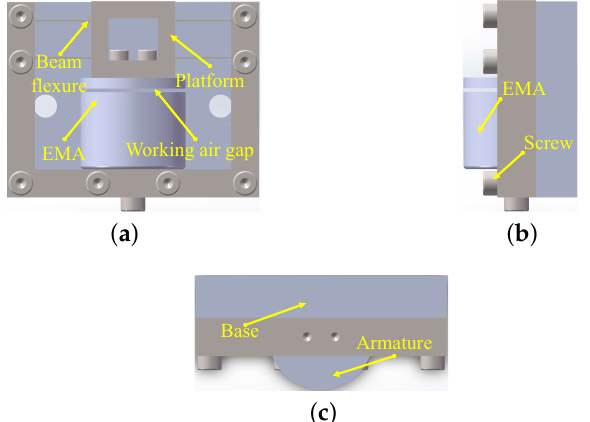
Figure 1. The diagrammatic model of EMA actuated micropositioner. ( a ) The front view of micropo- sitioner. ( b ) The end view of micropositioner. ( c ) The vertical view of micropositioner. According to the Equations (1)–(4), define x 1 = y , x 2 = ˙ y , x 3 = I c as the state variables